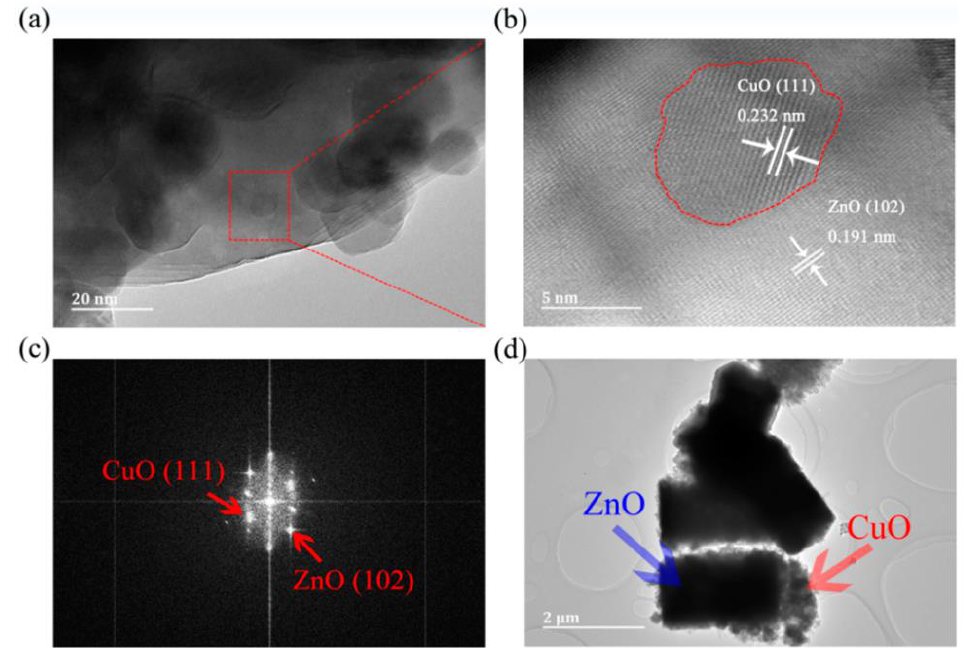
Figure 7. High-resolution transmission electron microscopy image the ZnO/CuO heterostructure: The CuO particles are loaded on the surface of ZnO ( a ). A magnified view of the enclosed regions: interface between ZnO and CuO particles is represented by a red dotted line ( b ). Fast Fourier transform (FFT) ( c ). Transmission electron microscopy image the ZnO/CuO heterostructure having a diameter of 1.00 – 1.21 µm and a height of 1.99 – 2.30 µm ( d ) [130].